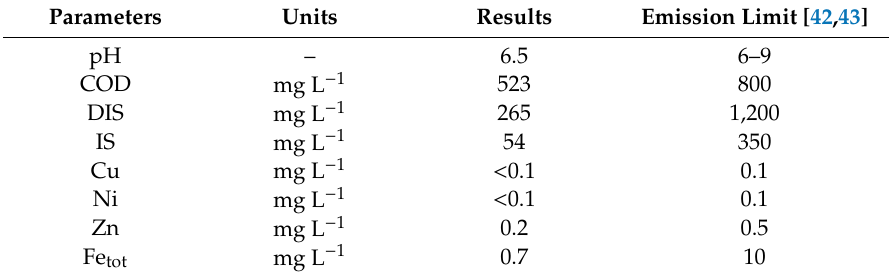
Table 7. Values after final pre-treatment before discharging wastewater into the company sewer system.